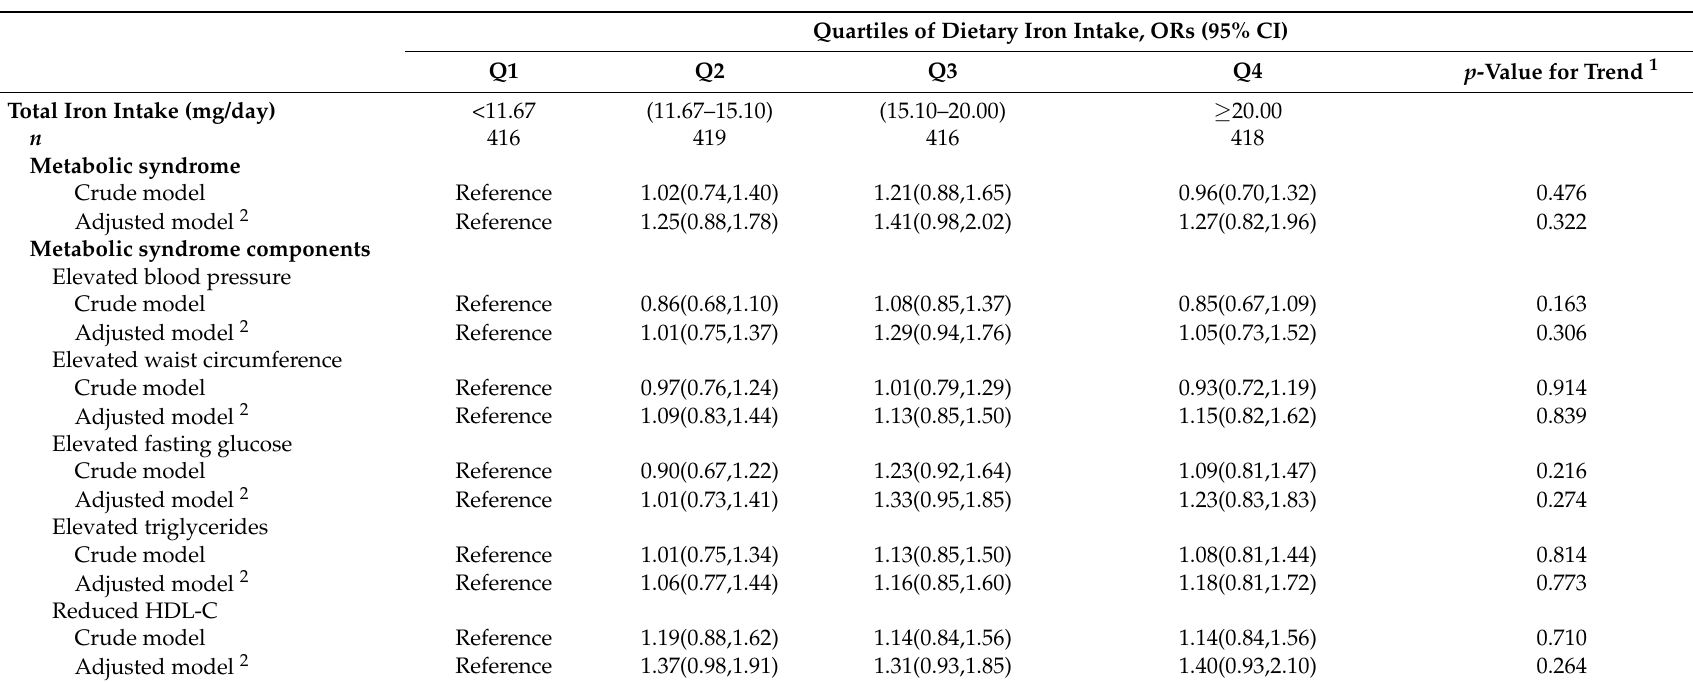
Table 8. ORs (95% CI) for metabolic syndrome and its components according to the quartiles of total iron intake (mg/day) among women in the SDHS